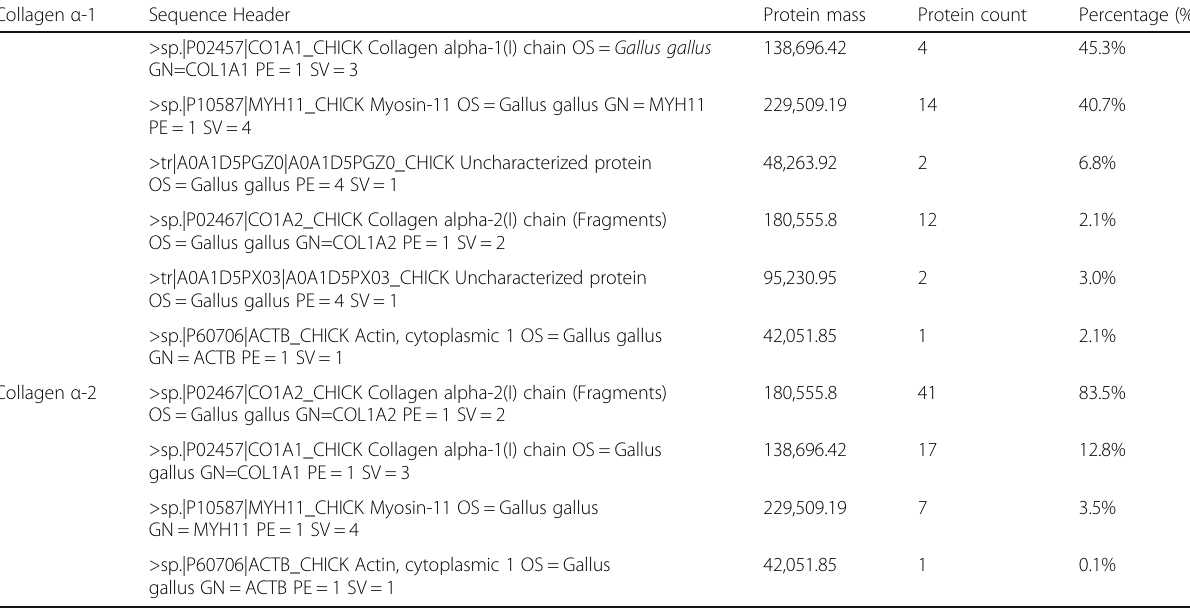
Table 3 Identified UPSC from chicken lung sample by LC-ESI-MS/MS sequencing and analysis Collagen α